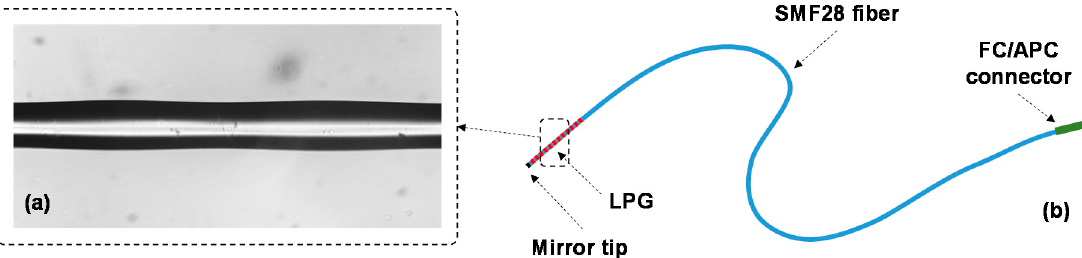
Figure 5. ( a ) Microscope image of the LPG fiber region showing period tapering due to EAD treatment; ( b ) Schematic of LPG fiber sensor configuration tested in the GC-5000 setup.